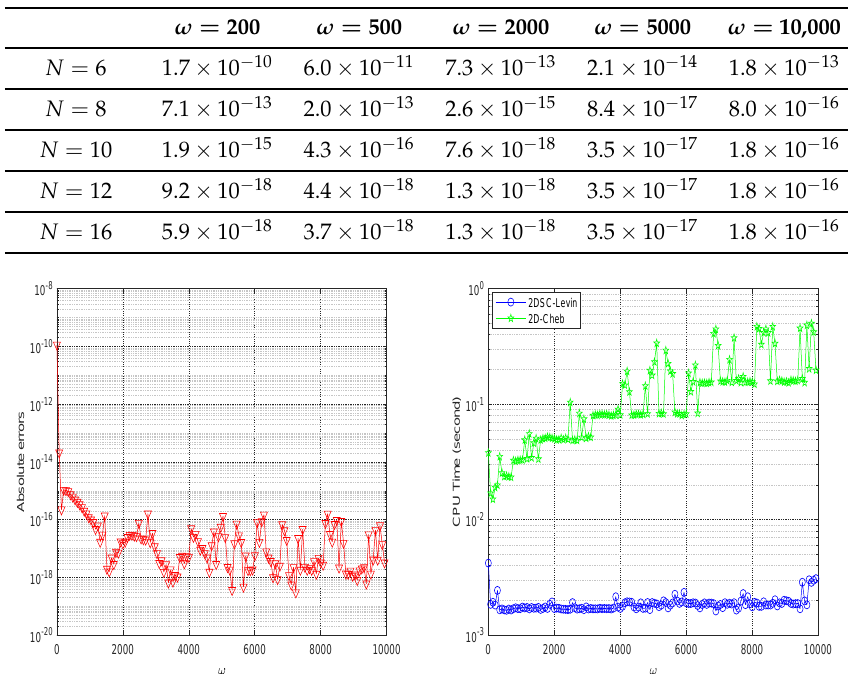
Table 3. Absolute errors of 2DSC-Levin for Example 1.